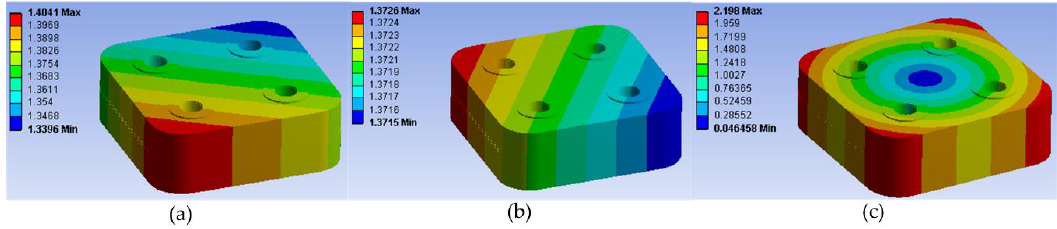
Figure 7. Modal shapes of di ff erent orders: ( a ) First order; ( b ) second order; ( c ) third order. Table 5. Statistics of different finite element modeling methods.